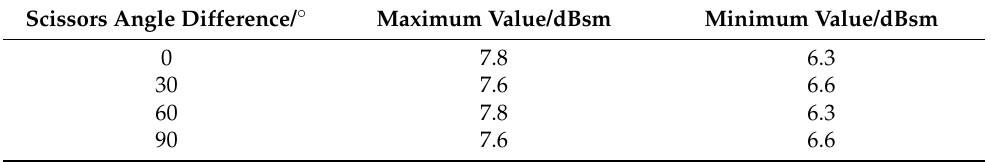
Table 11. Maximum and minimum average RCS values at an azimuth angle = 0 ◦ in helicopter mode. Scissors Angle Difference/